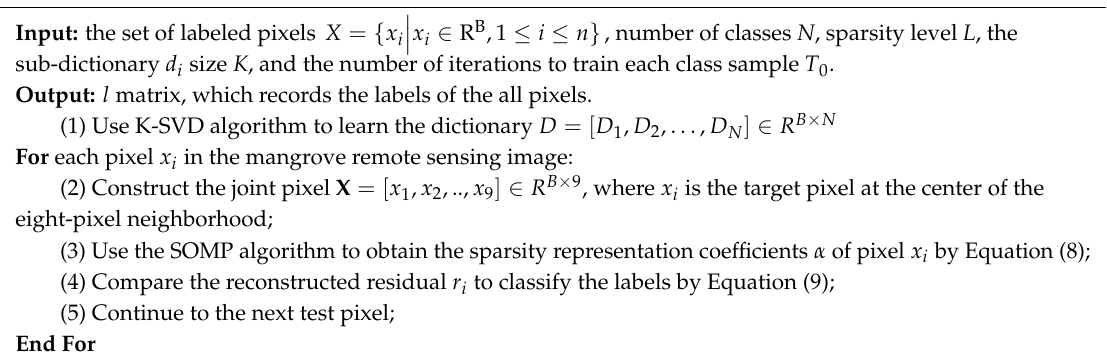
Algorithm 1: MF-SRU